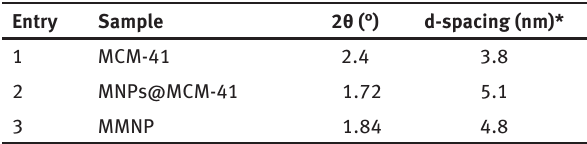
Table 1: d-spacing calculation of MCM-41, MNPs@MCM-41 and MMNP.